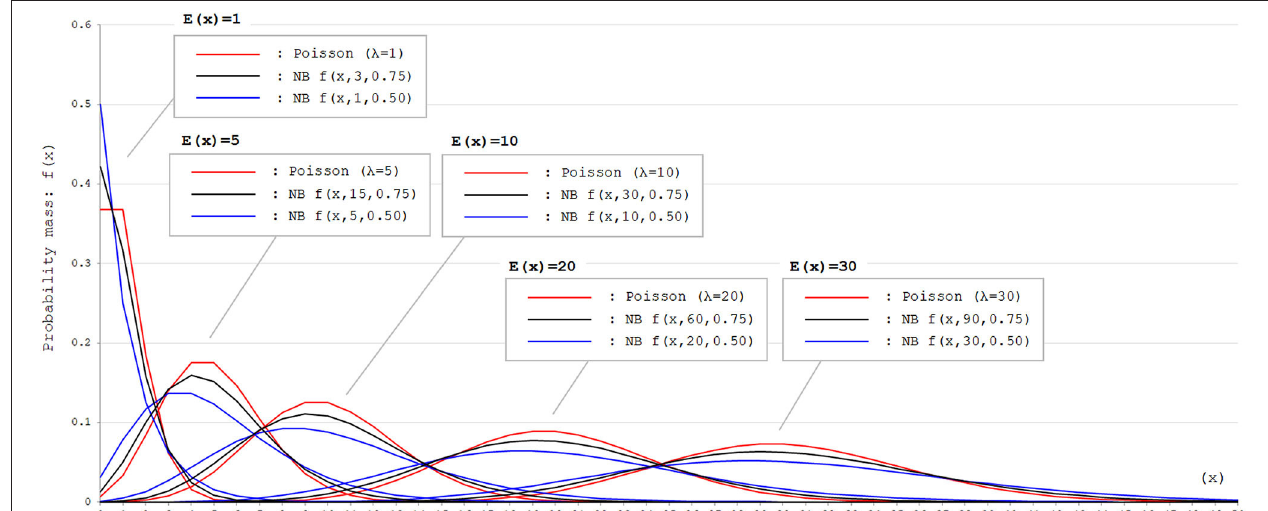
FIGURE 1 | Poisson and negative binomial distributions with different parameters. Poisson and negative binomial (NB) distributions with different parameters that generate E ( x ) 1, 5, 10, 20, and 30 are shown. The function for NB distributions [ f ( x , k , p ) ] denotes the probability mass of x failures by the time of k successes = NB ( k , p ) . As can be seen, negative binomial distribution can produce in trials with the successing probability of p in each attempt. This can be also expressed as X ∼ distributions with larger variance (dispersion) than Poisson distribution with appropriate parameters. In Poisson distributions, the expected values [ E ( x ) ] correspond to the rate parameter λ . In NB distributions, E ( x ) corresponds to k ( 1 − p ) . p